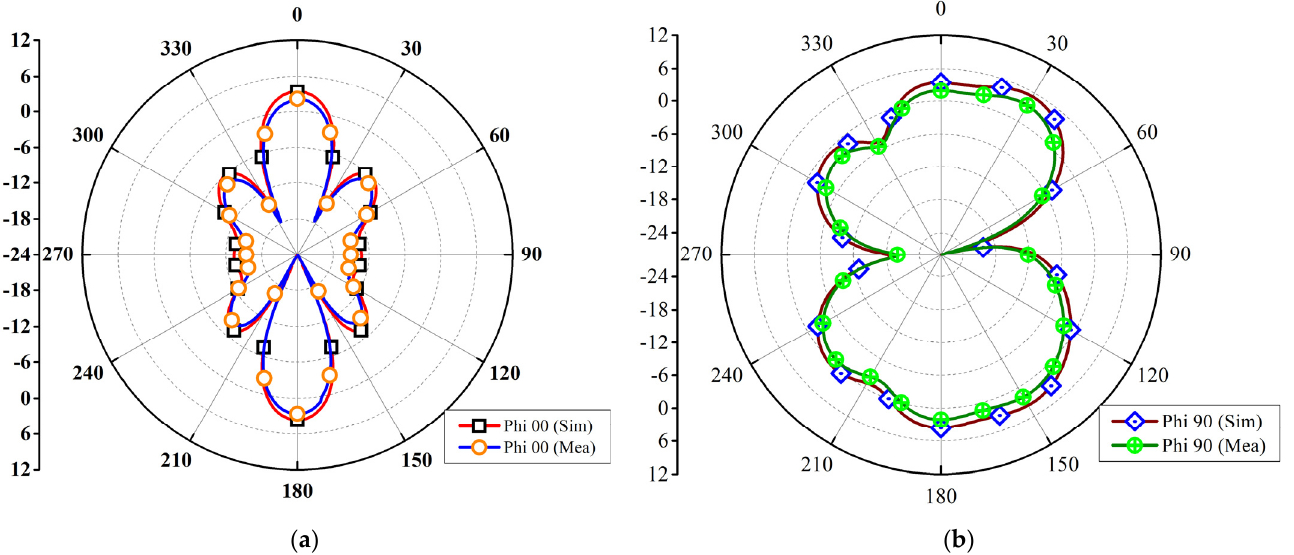
Figure 8. Radiation patterns at 28 GHz ( a ) Phi = 0 ( b ) Phi = 90.